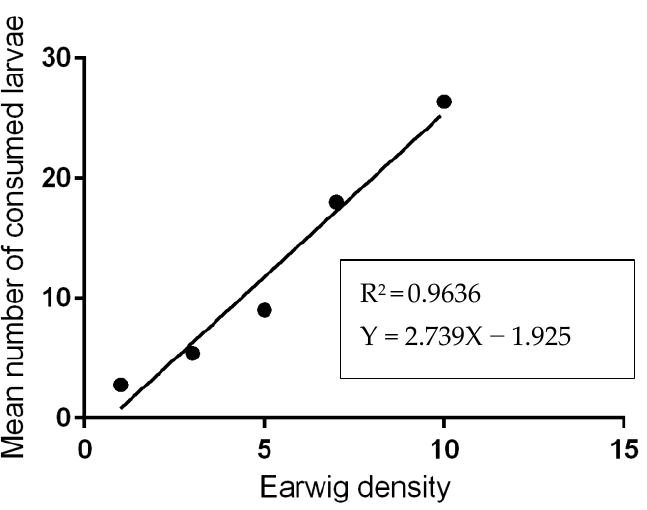
Figure 5. The number of larvae consumed by adult earwigs present in each ratio after 24 h. The plain line is the estimated linear regression (R 2 = 0.96, p = 0.003)